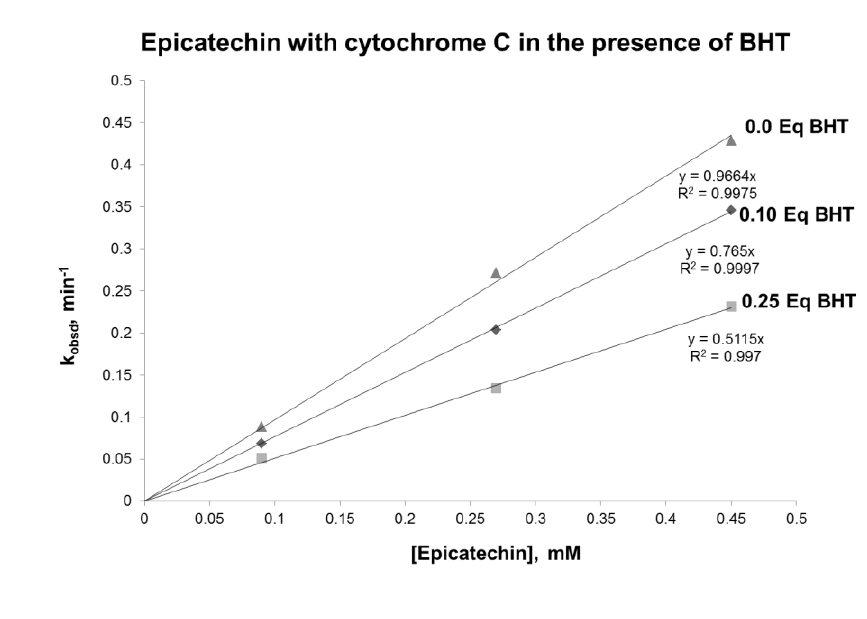
Figure 5. Plot of pseudo-first order rate constant, k obsd , vs. the concentration of epicatechin in the presence of 0.0.1 and 0.25 equivalents of BHT (butylate